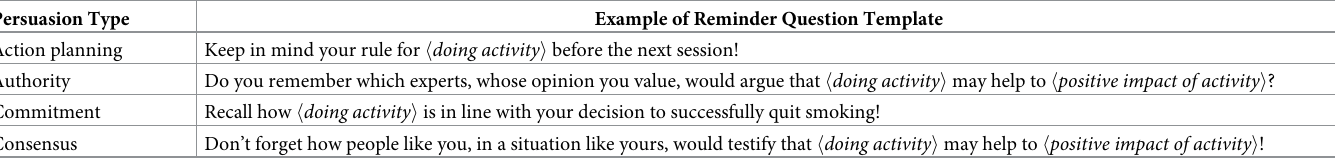
Table 4. Examples of reminder question templates. Examples of templates for the reminder questions that are added to the reminder messages people receive. Persuasion